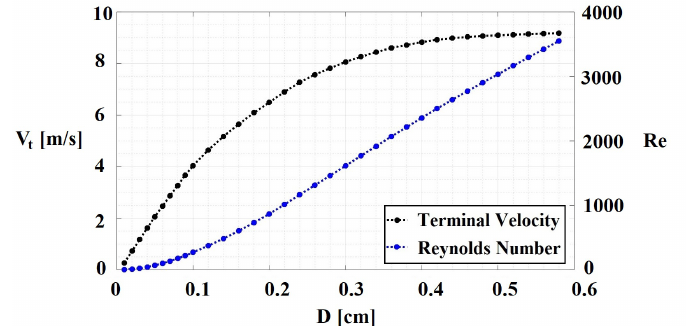
Figure 2. Terminal velocities and the corresponding Reynolds numbers for water drops of various diameters in stagnant air; data taken from Gunn and Kinzer